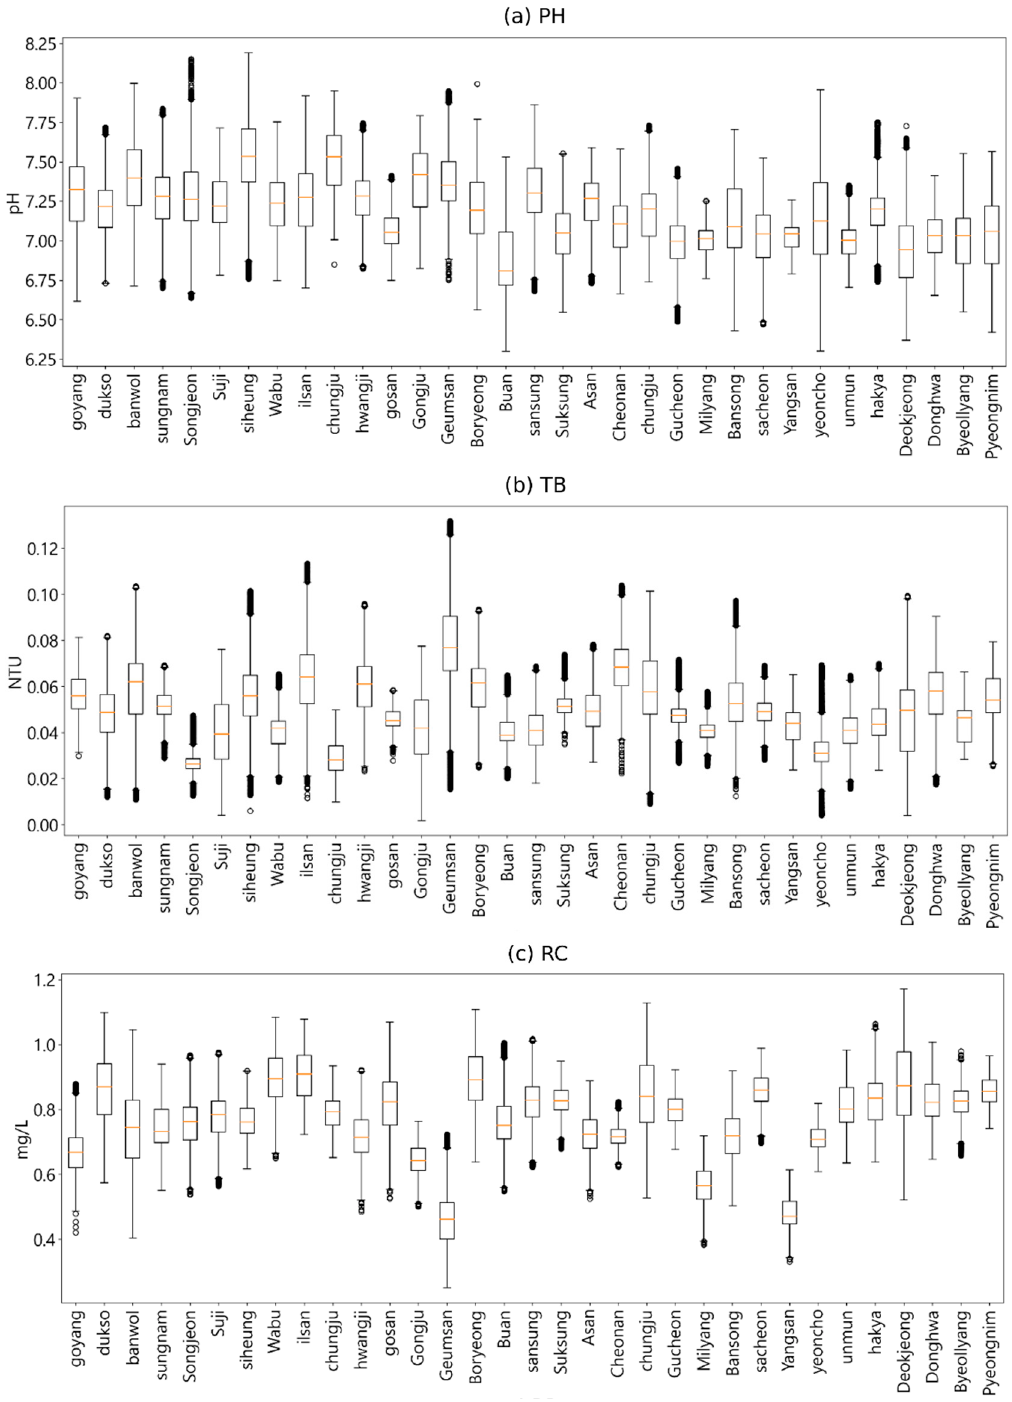
Figure 3. Descriptive statistics of the water quality parameters analyzed in this study: ( a ) PH, ( b ) TB, and ( c ) RC.